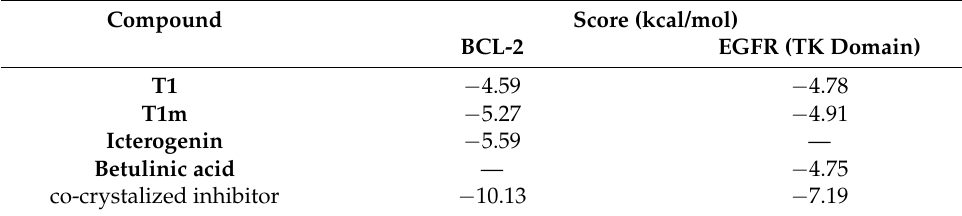
Table 2. Docking scores for compounds T1 and T1m